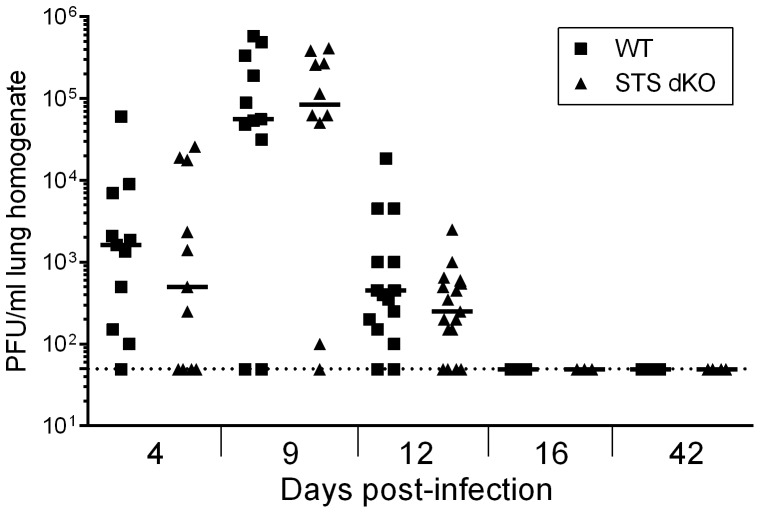
Sts dKO T cells do not alter the kinetics or levels of acute replication in the lungs.Sts dKO and C57BL/6 WT mice were infected 1000 PFU of MHV68 by the intranasal route. Lungs were harvested and disrupted at the indicated timepoints to quantitate levels of pre-formed infectious virus. Bar indicates median of log10 transformed data; dashed line indicates limit of detection. 3–8 animals are included per replicate experiment, n = 3 for 4 dpi, n = 2 for 9 dpi, n = 2 for 12 dpi, and n = 1 for 16 and 42 dpi; no significant differences were found based on Mann-Whitney non-parametric t-tests.